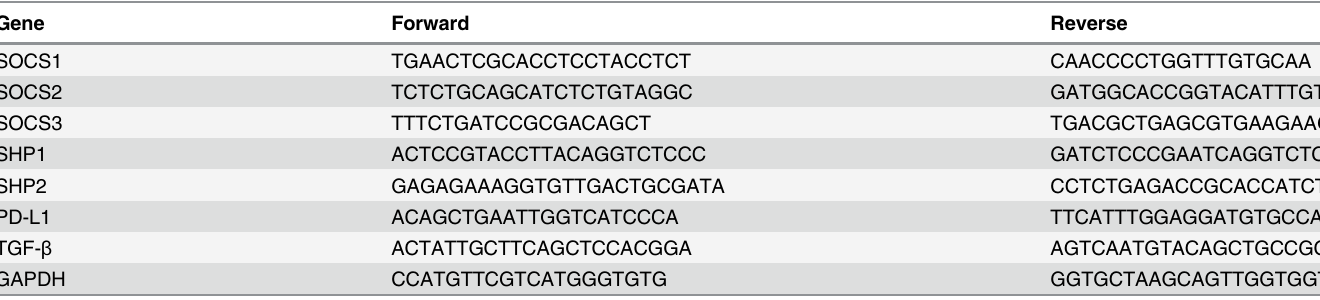
Table 1. Oligonucleotide primers for quantitative